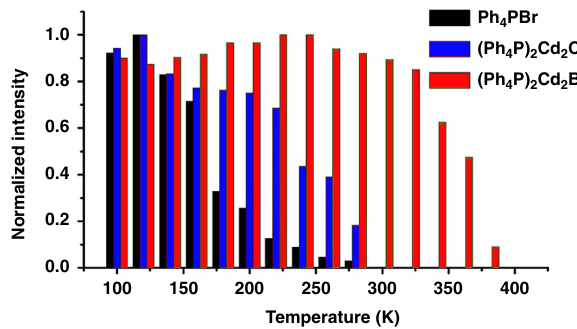
Fig. 4 Comparison of temperature in fl uence on room-temperature performance. Temperature-dependent intensity of emission (at 500 nm) (Ph 4 PBr: 100 – 300 K; (Ph 4 P) 2 Cd 2 Cl 6 : 100 – 300 K; (Ph 4 P) 2 Cd 2 Br 6 : 100 –